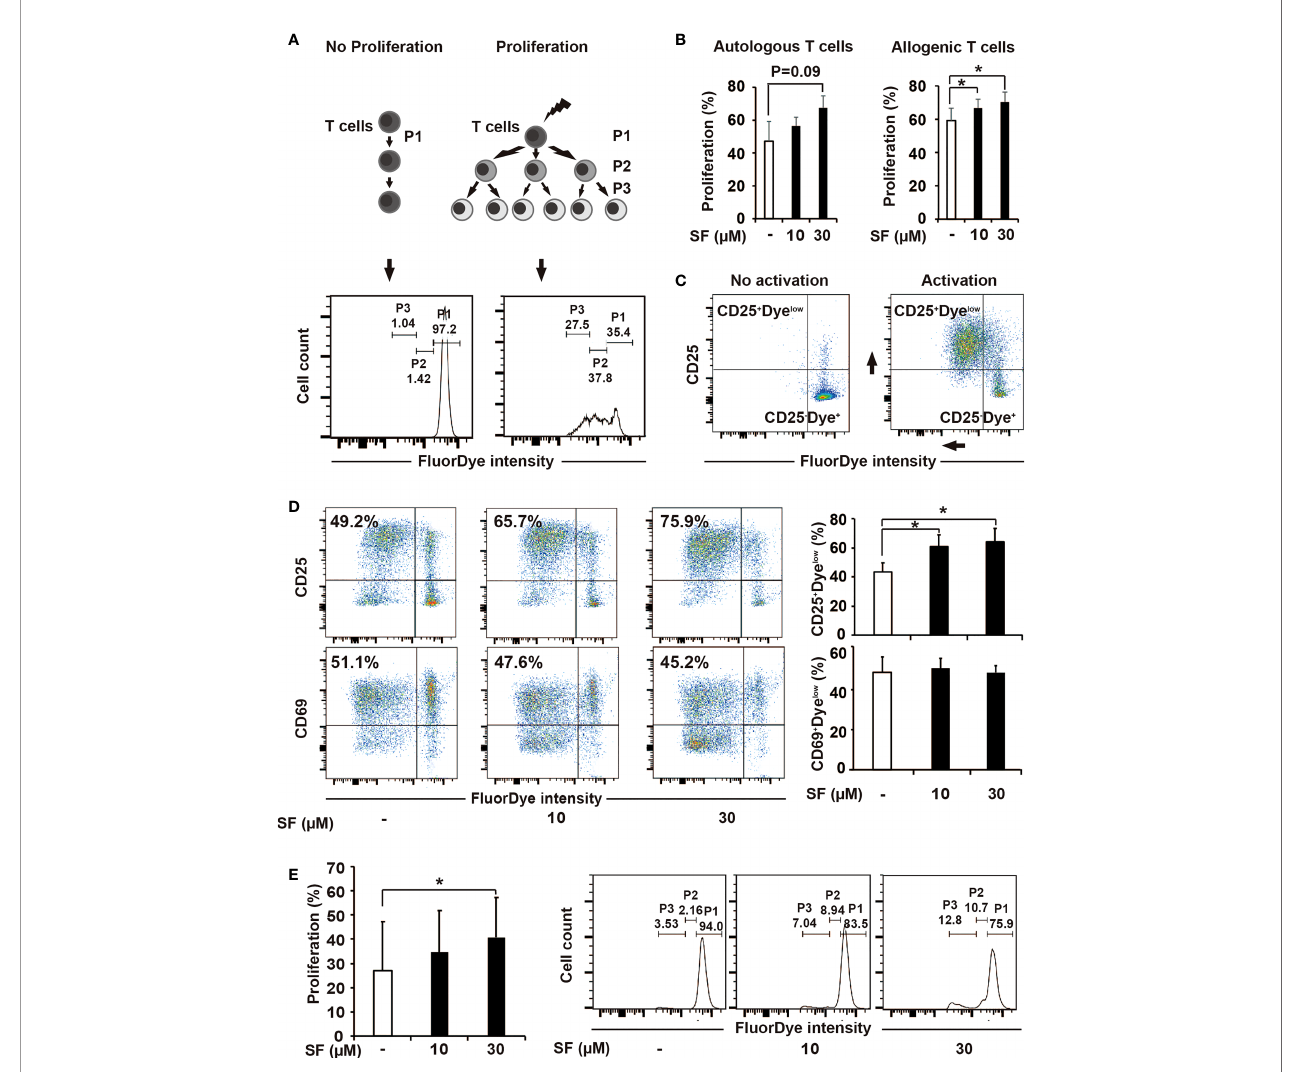
FIGURE 2 | Sulforaphane improves stimulatory capacity of dendritic cells (DCs). (A, B) The principle and evaluation of proliferation assay. (A) Difference in the activation ability towards T cells was assessed by the distribution of FluorDye among proliferating cells. The representative histograms show the gating strategy of a non-proliferating (P1) and proliferating T-cell populations (P2 and P3) in negative and positive control. The numbers indicate different percentages of each portion from one representative experiment. (B) Mature monocyte-derived dendritic cells (MoDCs) were treated with sulforaphane (SF) at indicated concentrations or vehicle control for 48 h. The same amount of DCs were co-incubated with autologous or allogenic FluorDye-labeled peripheral blood mononuclear cells (PBMCs) at ration 1:10 for 5 days, with the addition of CD3/CD28 puri fi ed antibodies. The proliferation of T cells was analyzed by fl ow cytometry and FlowJo software. The sum of P2 and P3 percentage was used as a Proliferation percentage (%), n = 4. (C, D) The principle of assessment and evaluation of T-cell late activation marker CD25. (C) The dot plot on the left indicates a non-proliferating T-cell population (negative control), composing to a large extent CD25 - Dye high population. During T-cell activation (positive control), FluorDye distributes among daughter cells leading to the FluorDye signal shift to the left in X-axis, and the CD25 shift in Y-axis, forming CD25 + Dye low population. Representative dot plots are shown. (D) Co-incubation of DCs and PBMCs was performed as in 2B. Cells were labeled with CD25-V450 and CD69-APC-Cy7 antibodies and analyzed by fl ow cytometry and FlowJo software. The data are presented as mean ± SD. Dot plots provide the data from one representative experiment, n = 4. (E) Sulforaphane affects stimulatory capacity of DCs in presence of pancreatic cancer antigens. Tumor lysate was prepared and used to treat MoDCs for 24 h. MoDCs were matured and treated with sulforaphane at indicated concentrations or vehicle control for 48 h. The co-incubation was performed and analyzed as shown in (B) . Representative histograms are shown on the right, n = 4. *P ≤